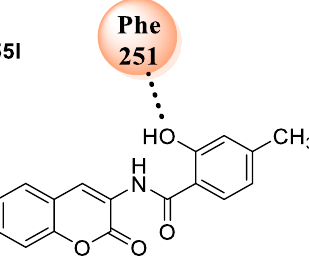
Figure 4. Compound 55l docked within the active site of 1W9U.